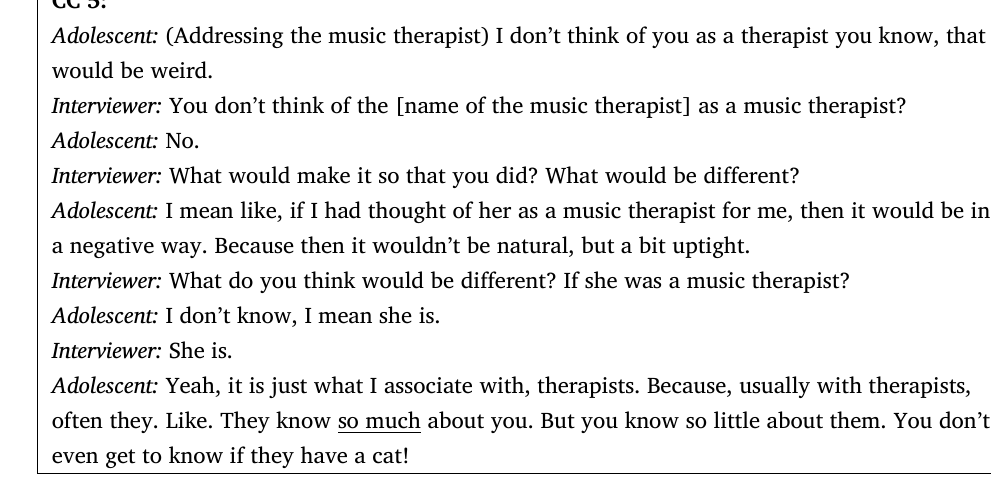
Fuhr and Stensæth. Voices 2022, 22(3).